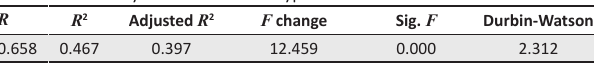
TABLE 7: Summary of the model for Hypotheses 10.